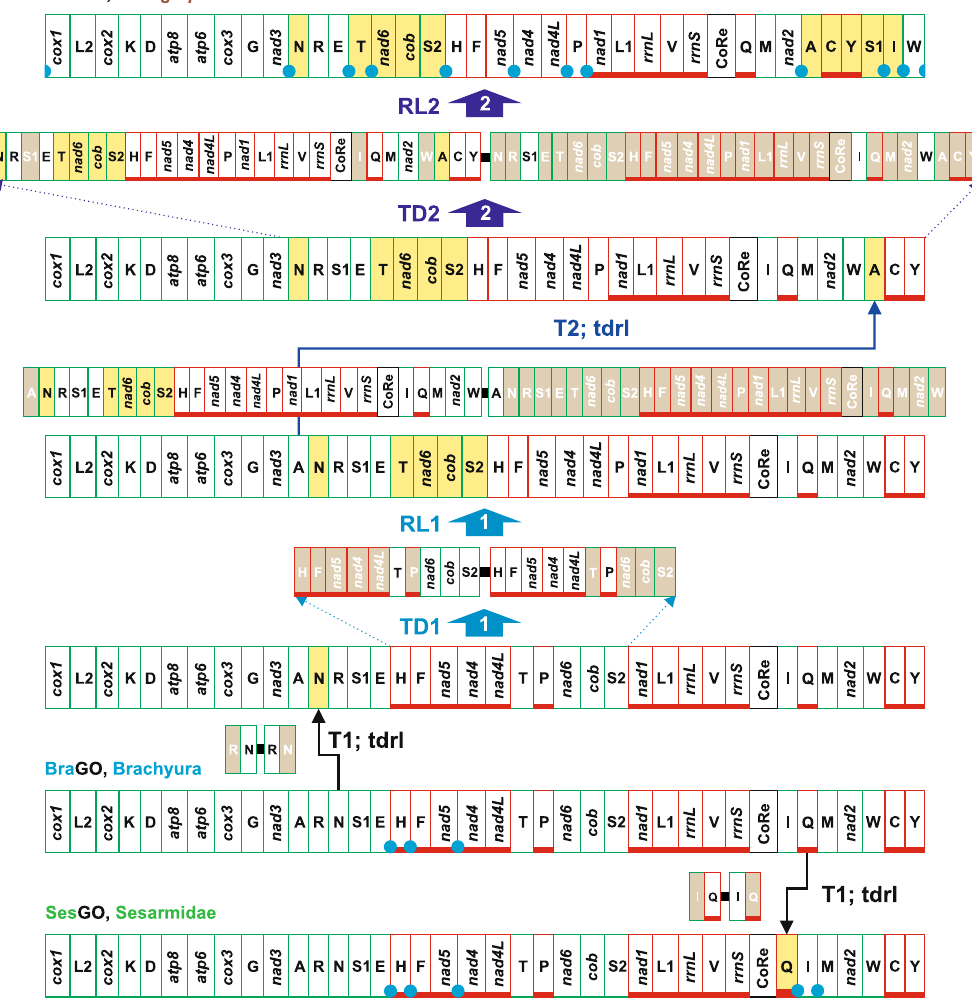
Figure 7. The evolution of GOs in Sesarmidae and X . testudinatus . The rearrangements in the GOs of Sesarmidae and X . testudinatus are investigated and depicted with respect to BraGO. T1-T2, transpositions event; tdrl, tandem duplication random loss mechanism producing the observed rearrangement. TD/RL1-2, tandem duplication/random loss events. The genomic and genetic nomenclature, as well as the colour scheme, are the same as in Fig. 1. The genes that changed their position relative to PanGO, through a transposition event, are shown with a yellow background. The passively-shifted genes are figured with their original background. A blue circle marks an intergenic spacer present in a position associated to genomic